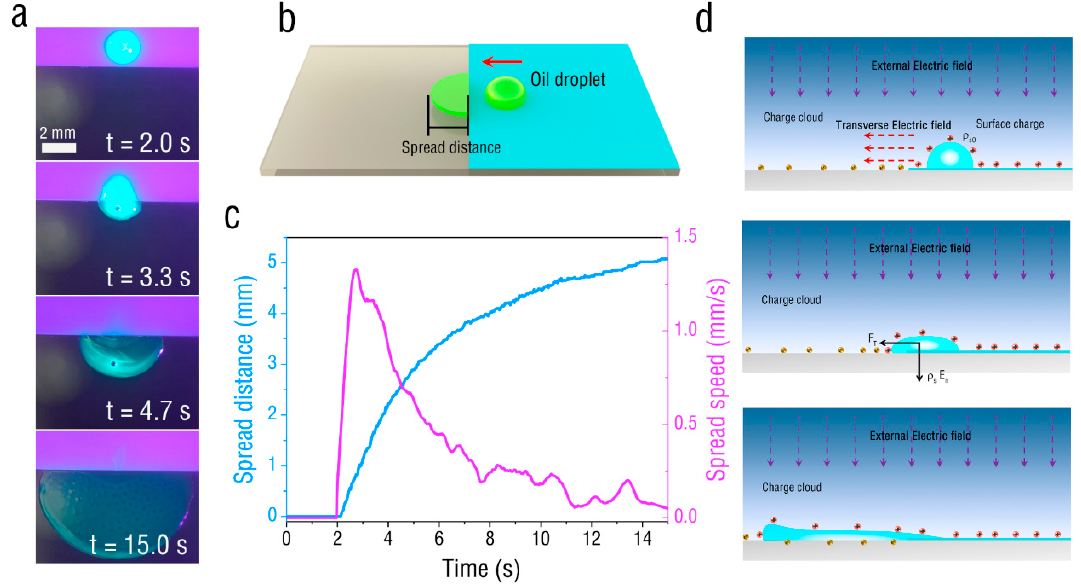
Figure 3. Spread of oil droplets on the ITO glass. ( a ) Spread behaviors of oil droplet driven by corona discharge with voltage of 8 kV. ( b ) Schematic diagram of the experimental case. ( c ) Variation of spread distance and spread speed of oil droplets with time. ( d ) Electrical principle of oil droplet spread movement.